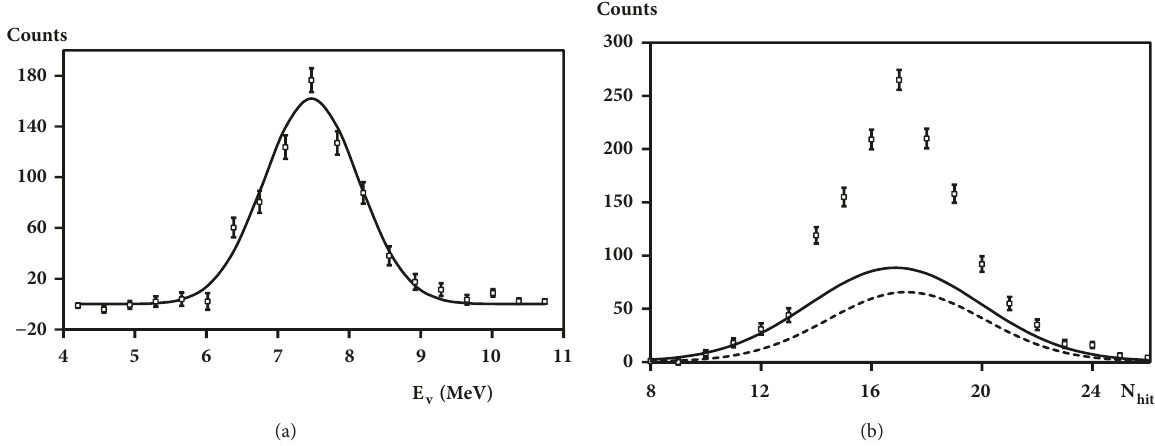
Figure 8: Evidence for a neutrino line centered on 7.5 MeV in the Kamiokande-II data taken on the date of SN 1987A from [18]. (b) shows a histogram of the raw data taken in the hours before and after the main burst, with 𝑁 ℎ𝑖𝑡 being a proxy for the neutrino energy, 𝐸 ] , and the solid and dashed curves being two versions of the background for the detector. After subtracting the background (obtained from other K-II data) and converting the horizontal scale to neutrino energy, one obtains (a) the background-subtracted curve.